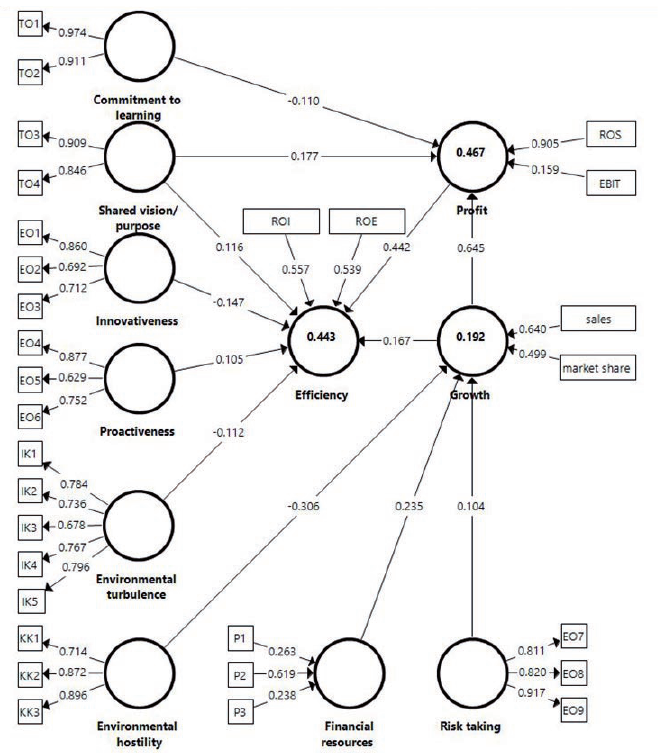
Fig. 2 – PLS-SEM results with significant (p<0.05) path coefficients. Source: own